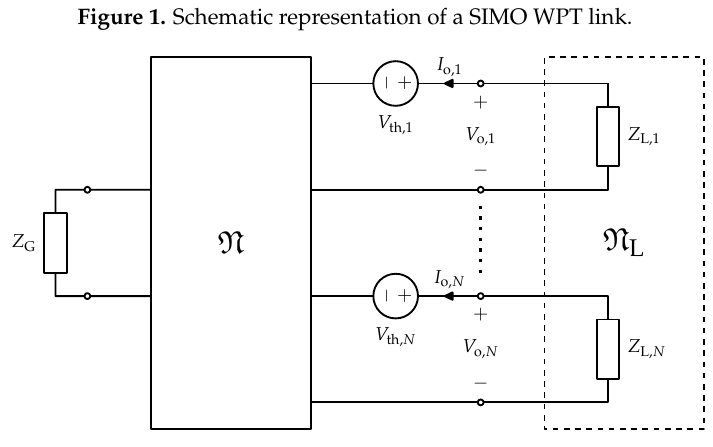
Figure 2. Equivalent Thévenin representation of the circuit of Figure 1.